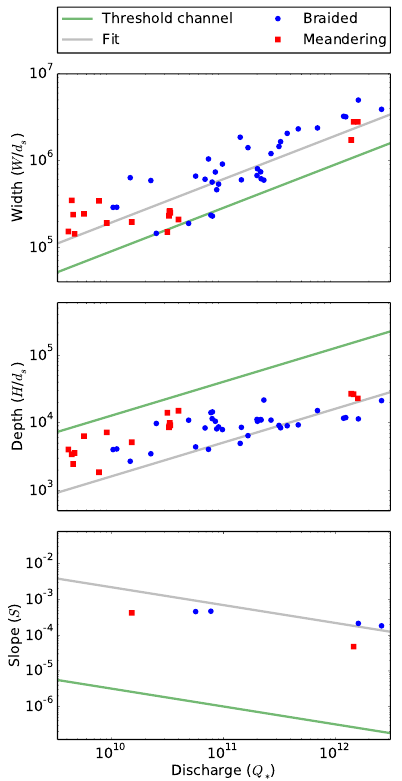
Figure 5. Dimensionless width, depth and slope of the threads as functions of the dimensionless water discharge. Empirical regime relationships obtained by RMA are shown in dashed lines (see Ta- ble 1 for details).